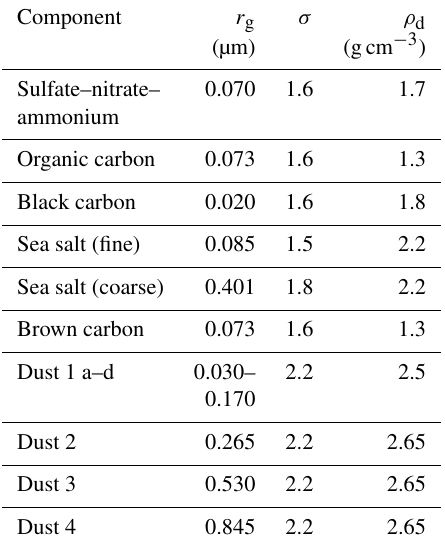
Table A2. Current microphysical properties of each aerosol species in GEOS-Chem. r g represents the dry geometric mean radius (µm) and σ the geometric standard deviation of the lognormal size distributions assumed for each species. ρ d represents the dry mass densities of each species (gcm − 3